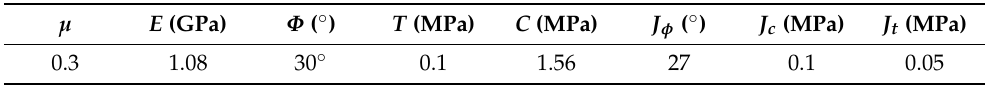
Table 1. Mechanical parameters of the surrounding